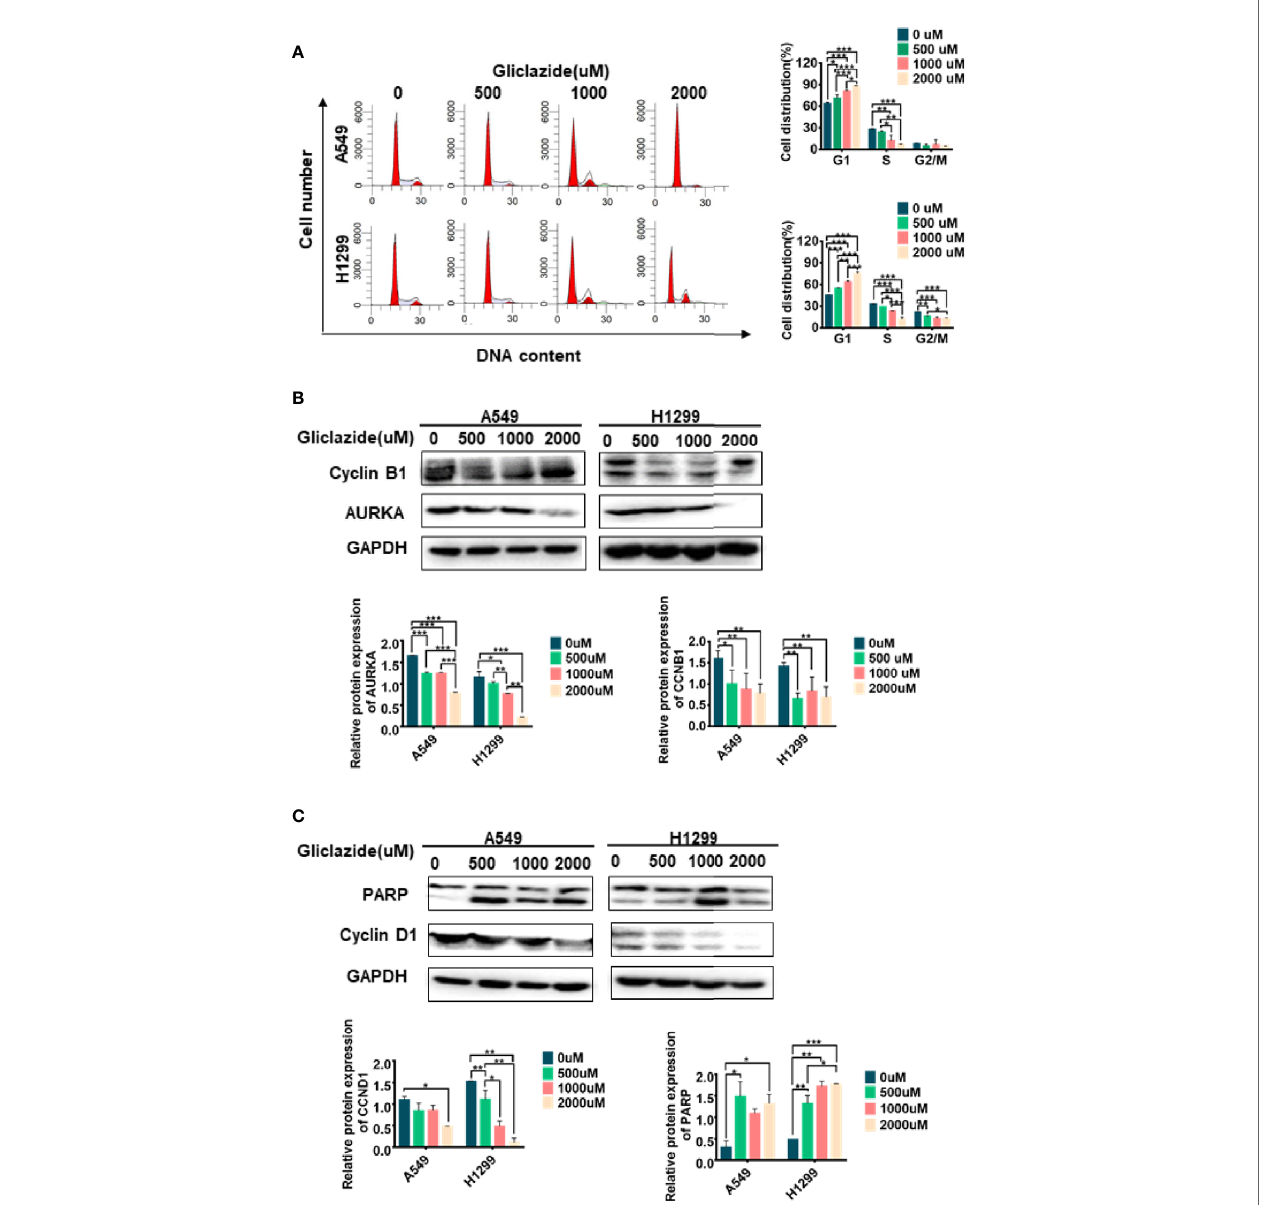
FIGURE 8 | Experimental veri fi cation of Gliclazide on cell cycle and apoptosis. (A) Effect of the gliclazide on cell cycle distribution of A549 and H1299 cells exposed to gliclazide for 48 h. Histograms of cellular DNA content obtained by fl ow cytometry have been represented. (B , C) Protein expression of CyclinD1, cyclin B1, AURKA and PARP were quanti fi ed via western blotting, with GAPDH as the loading control. One-way ANOVA was used for statistical analyses. Data are plotted as mean ± SD. P values are labeled in the fi gures. *P < 0.05; **P < 0.01; ***P <